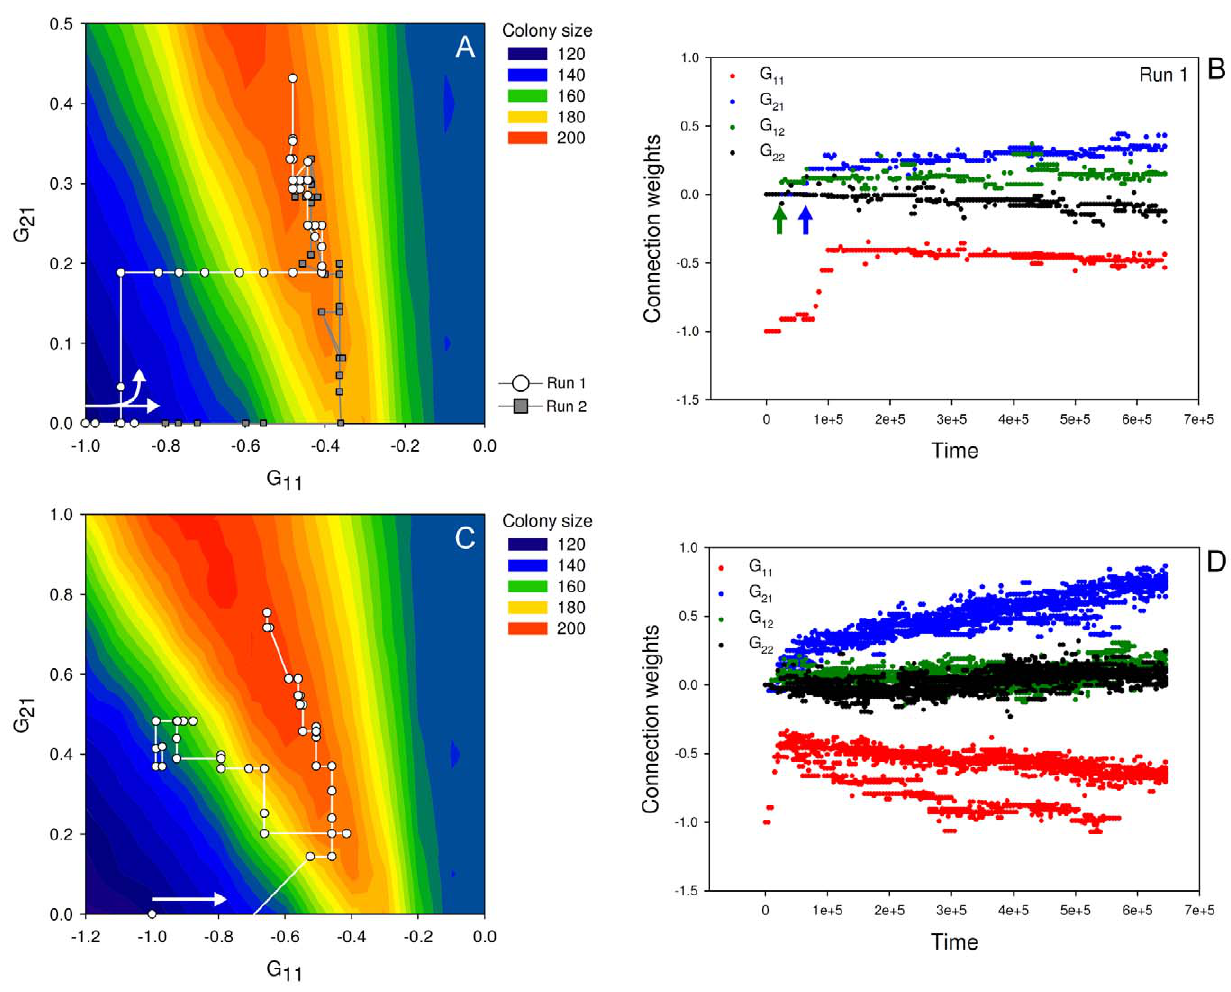
Figure 3. The evolution of cell-to-cell communication under clonal and non-clonal growth conditions. The upper panel (plot A and B) shows the clonal growth conditions ( L ~ 1 ). The lower panel (plot C and D) shows the non-clonal growth conditions ( L ~ 10 ). The left plot in each panel (plot A & C) shows the evolutionary trajectory (645.000 time steps with 5.000 time step intervals) plotted on an adaptive landscape. Thereby illustrating the evolution of cell-to-cell communication. The right plot (plot B & D) in each panel shows the connection weights of the most-abundant genotypes (present in the population in more than 100 copies). These figures thereby show both the evolution of signal sensitivity and signal production. In addition, they show how sporulation depends on the nutrient concentration ( G 11 ). The adaptive landscapes (background coloration of plot A and C) are generated by growing each genotype—meaning each combination of G 11 and G 21 —clonally and taking the average colony size at 1 and h 2 v 0 ). The white arrows within plot A and C show the end of a nutritional cycle as fitness measurement (assuming that G 12 ~ G 22 ~ 0 , h 1 ~{ 2 the onset of the evolutionary trajectory, as well as the direction of evolution. The arrows in plot B indicate when signal production ( green arrow) and signal sensitivity ( blue arrow) evolved. The parameter settings are the following: d cell ~ 0 : 05 , d spore ~ 0 : 0005 , P max ~ 0 : 1 , K X ~ 400 , D Signal ~ 0 : 5 , t ~ 10 , C ~ 1 : 5 , C CD ~ 2 : 0 , X Input ~ 2000 , s X ~ 1000 , N 0 ~ 100 , S 0 ~ 0 , T ~ 200 , M ~ 200 , m rate ~ 0 : 0005 and m size ~ 0 : 05 .